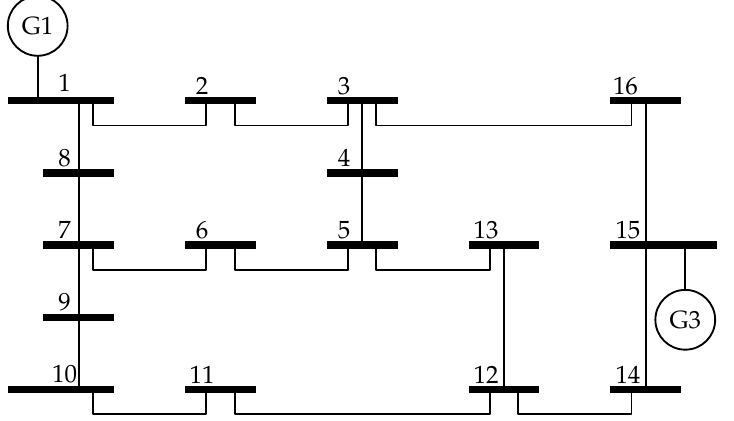
Figure 8. Diagram of the 16-bus system used in tests. Node 1 is a slack bus. Generator G3 represents a PV